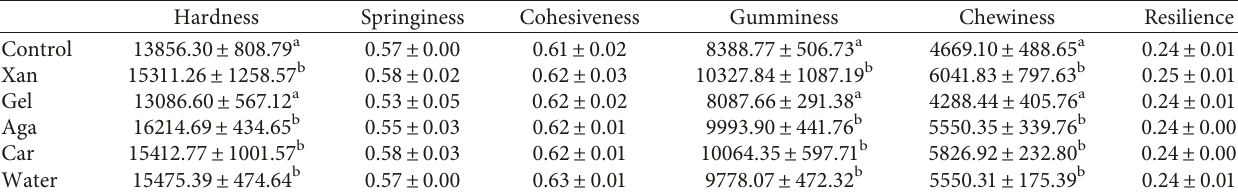
Table 3: Effects of different hydrocolloids in intramuscular injection on texture properties of porcine meat.